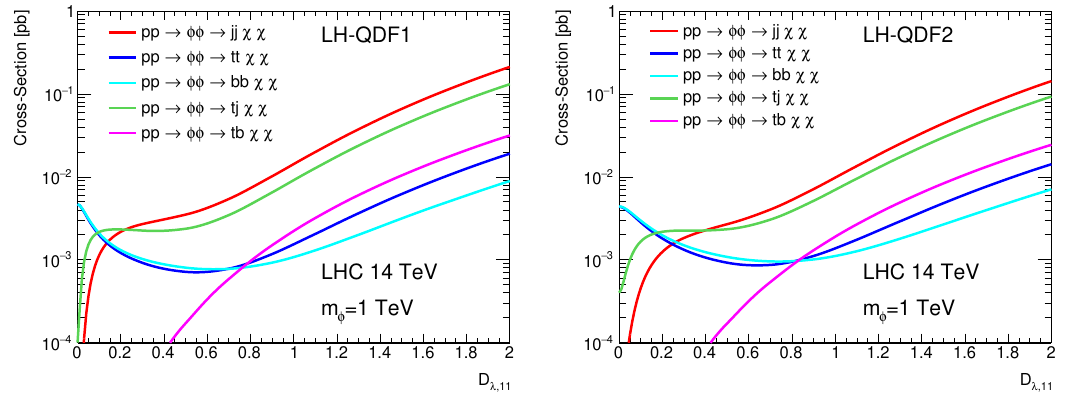
Figure 6 . Production cross-section for the different final states resulting from pair production of mediators at a 14 TeV LHC for the two LH benchmarks as a function of D right: LH-QDF2. The assumed mediator mass is 1